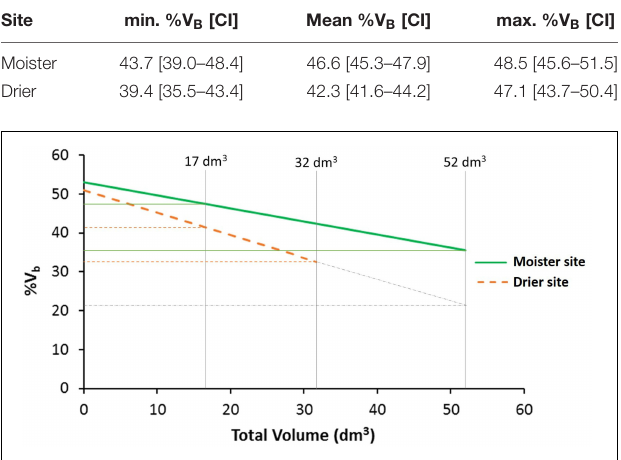
FIGURE 3 | Percentage of bark volume vs. total volume per site. Vertical lines indicate the global mean total volume for both sites (17 dm 3 ), and the maximum total volume reach at each test site (32 dm 3 at the drier site and 52 dm 3 at the moister site). Gray dot-dash lines represent the percentage of bark volume in the drier site if the trees would reach the same maximum total volume as in the moister site. At higher total volume, the difference between sites increases ( n = 512